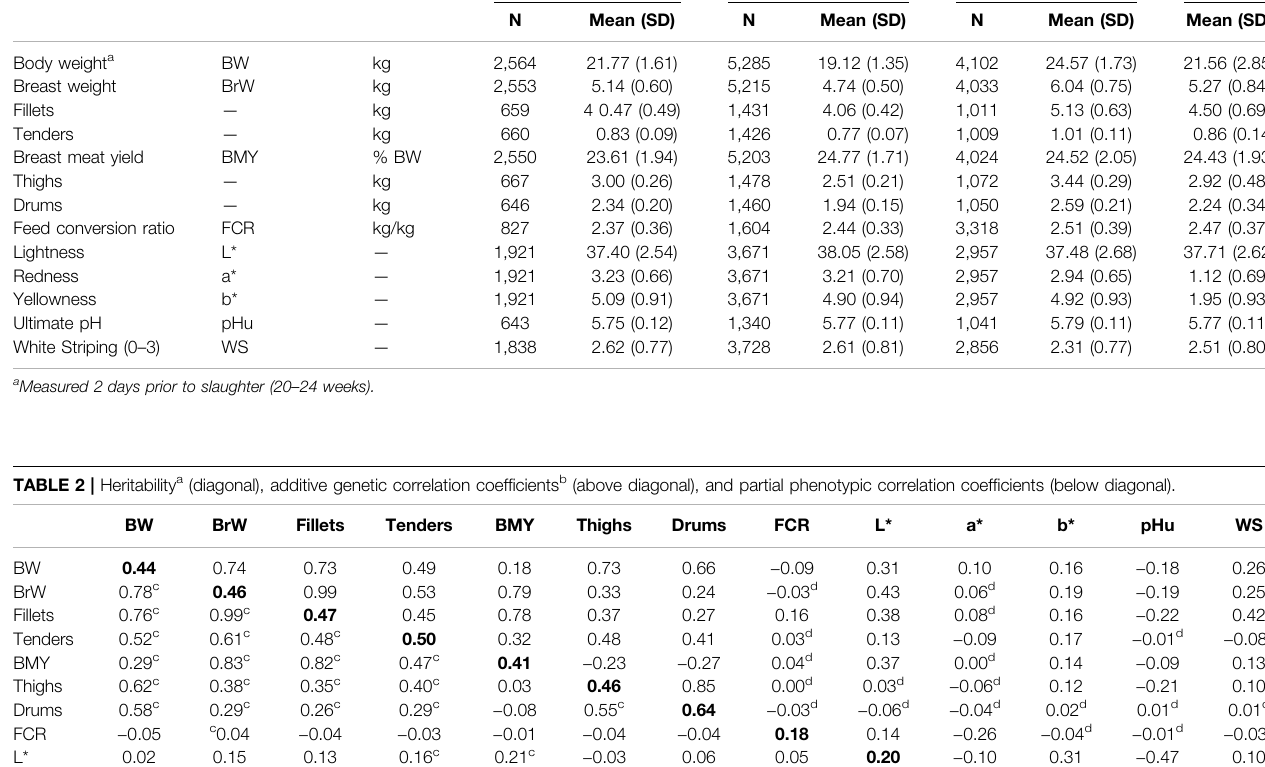
TABLE 1 | Descriptive statistics (count, mean, and standard deviation) for the 13 recorded traits. Traits were recorded on three purebred genetic lines. Trait